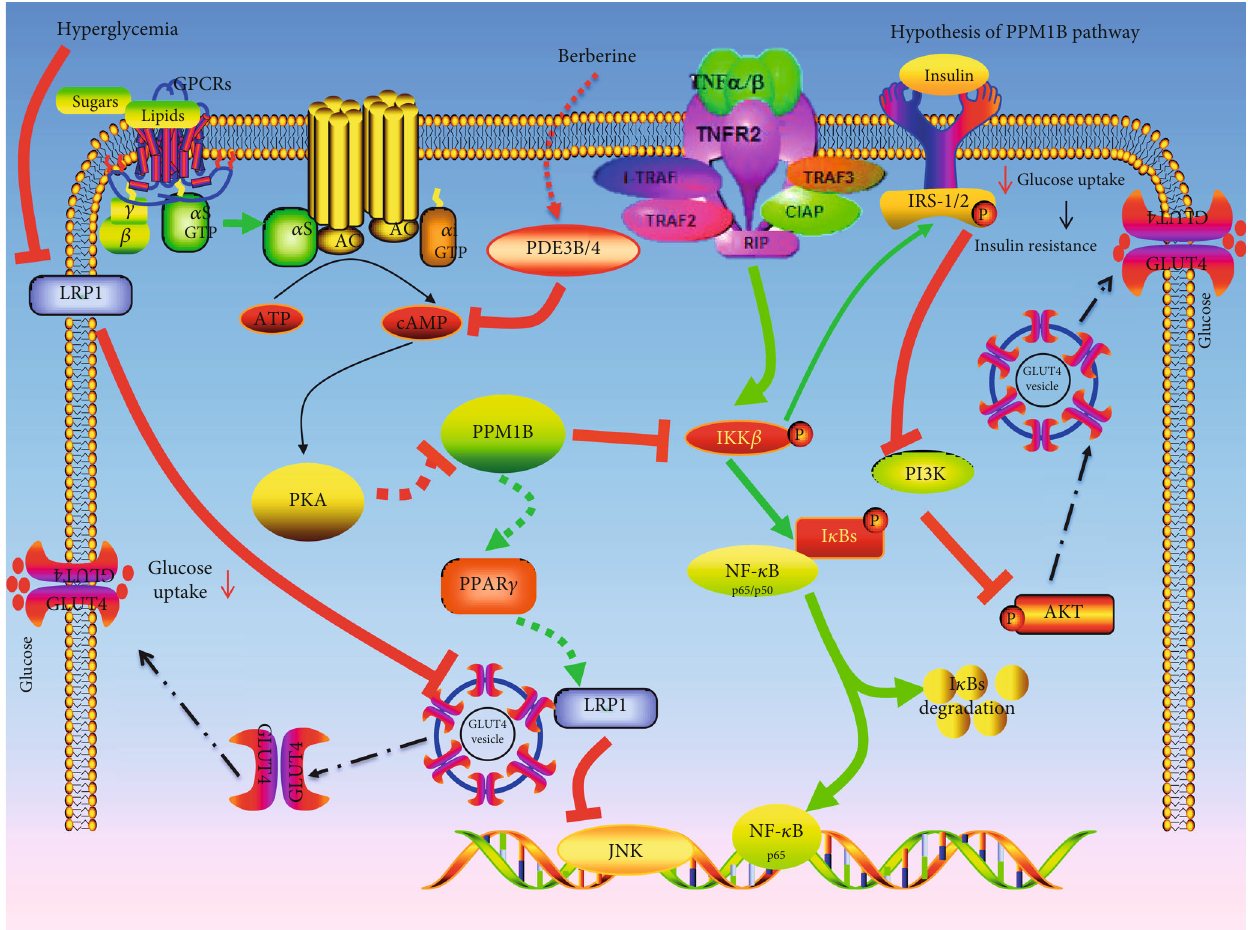
Figure 12: PPM1B interacts with IKK β through which it regulates activation of NF- κ B. LRP1 interacts with JNK and NF- κ B through which it regulates gene expression of JNK and NF- κ B. Hyperglycemia suppresses the levels of LRP1, which might further impair glucose homeostasis in the liver. LRP1 plays an important role in the regulation of glucose homeostasis by controlling glucose transporter levels. Activation of IKK β via the phosphorylation of Ser181 in IKK β , a serine phosphorylated kinase of the insulin receptor, contributing to phosphorylation of Ser307 in IRS-1 and Ser731 in IRS-2 to block insulin signal transduction to